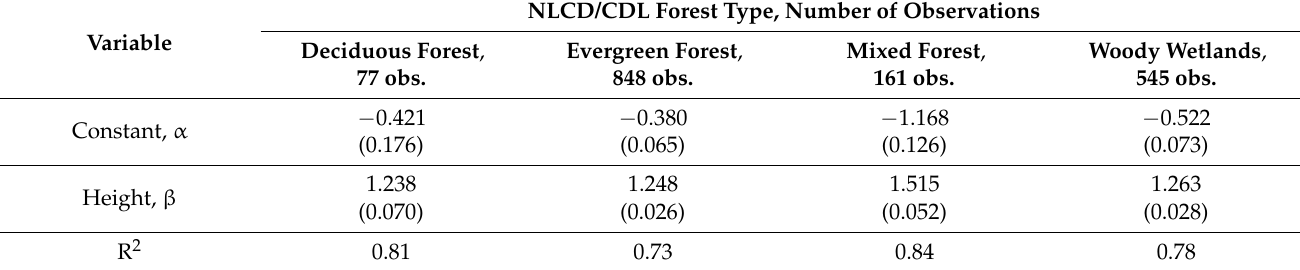
Table 5. Estimated tree diameters (DBH)–tree height (H) functions